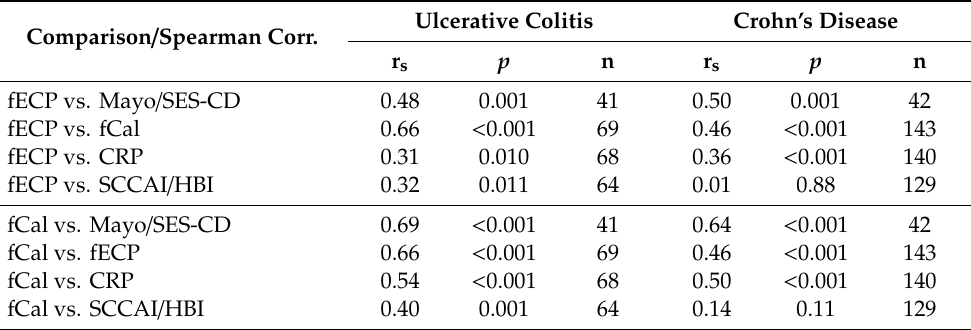
Table 4. Correlations of fECP with di ff erent disease activity markers. Comparison / Spearman